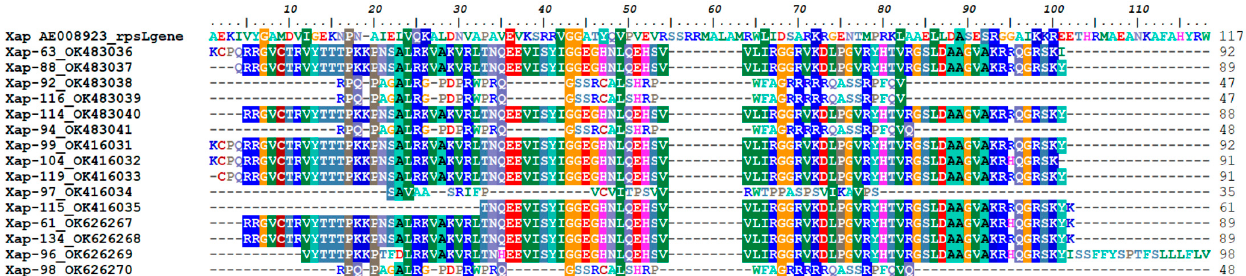
Figure 6. Multiple sequence alignment of rpsL protein from Xap isolates and the reference sequence retrieved from NCBI database using ClustalW.